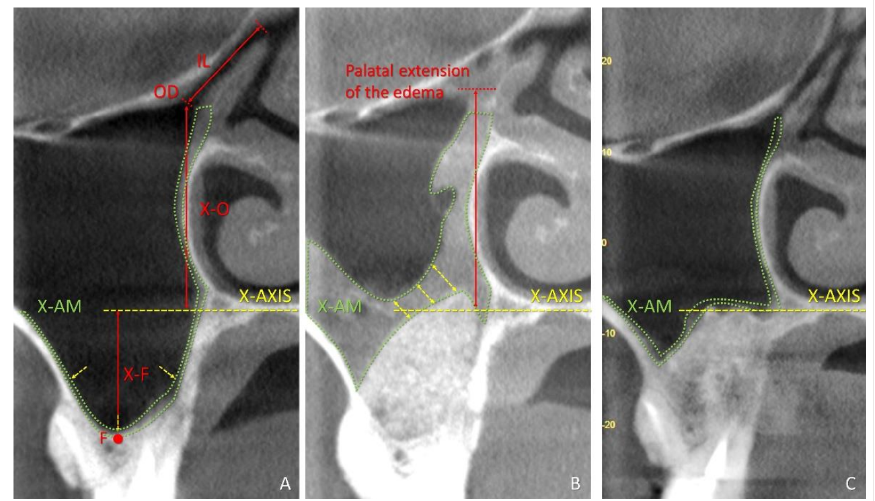
Figure 1. Coronal view of tomographic images of a maxillary sinus before surgery ( A ), and after 1 week ( B ) and 9 months ( C ). X-axis, nose floor; X-AM, area of the sinus mucosa (delimited by dotted green lines); IL, infundibulum length; OD, maxillary sinus ostium diameter; F, sinus floor; X-F, distance between X-axis and F; X-O, distance between X-axis and maxillary sinus ostium. Yellow arrows, positions of the measurements of the thickness of the mucosa. Note the loss of patency at ostium and infundibulum after 1 week from sinus floor elevation.